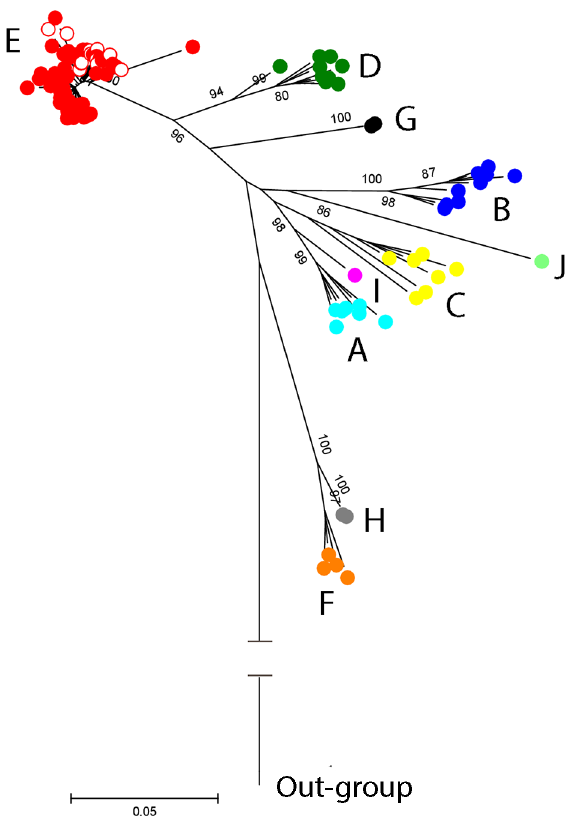
Fig 3. Phylogenetic reconstruction of world-wide and Offin river valley HBV sequences based on the pre-S/S region. A maximum-likelihood phylogenetic tree of HBV pre-S/S sequences obtained in this study (red dots) together with publically available sequences covering all HBV genotypes (multicolored dots) was constructed with 1000 bootstrap replicates using the Kimura 2-parameter +G +I model [41] contained in MEGA6 [42]. The tree is drawn to scale, with branch lengths corresponding to the number of substitutions per site. Reference sequences retrieved from GenBank are for genotypes A (AY233278, HE576988,